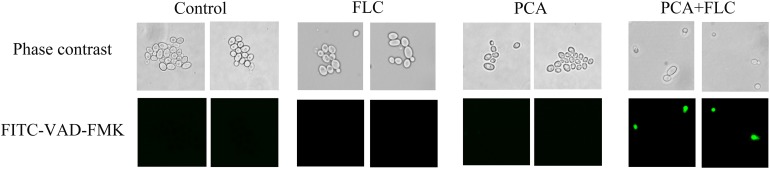
Effect of D-penicillamine (PCA) on the activity of metacaspase in Candida albicans. CA10 cells with FITC-VAD-FMK staining were observed under a fluorescent microscope after treatments with fluconazole (FLC) (0.5 μg/ml), PCA (128 μg/ml), and a combination of FLC (0.5 μg/ml) with PCA (128 μg/ml). The photographs were collected from three independent experiments.